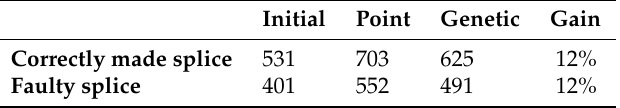
Table 3. Lengths of initial data matrices and output matrices after